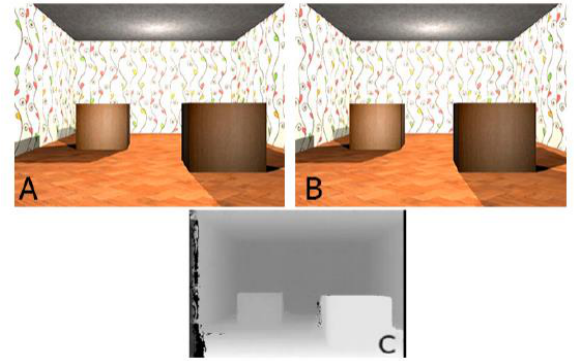
Figure 3. A - left camera image; B - right camera image; C - depth map obtained from the virtual environment map.